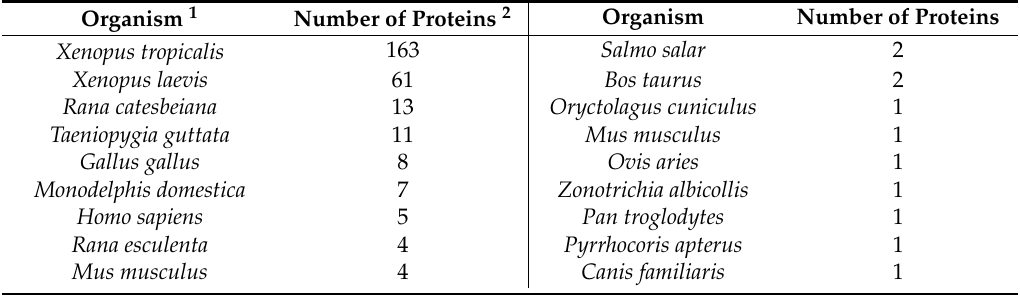
Table 2. The distribution of DEPs in different